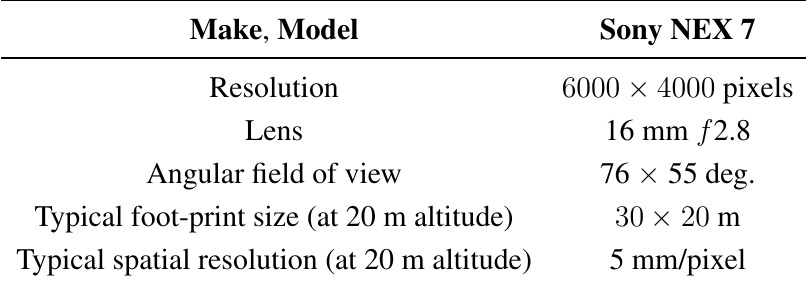
Table 2. Camera technical